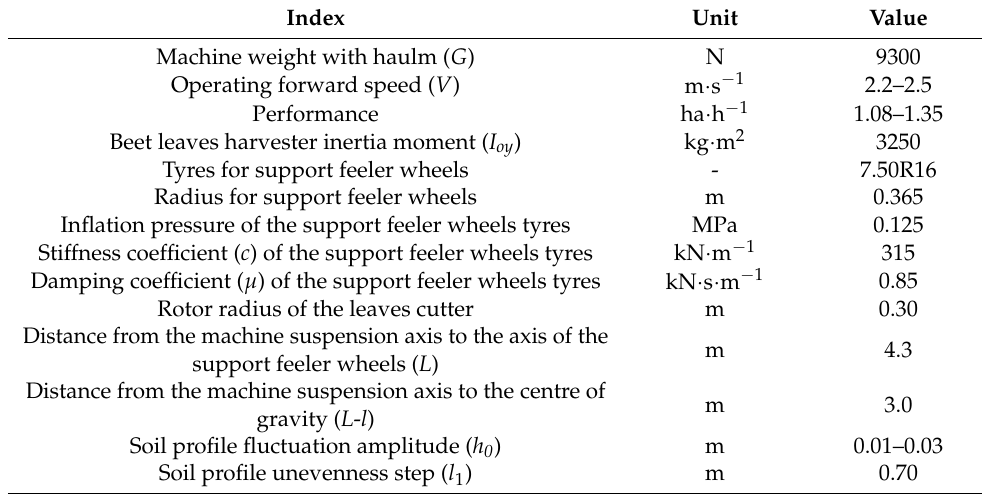
Table 1. Main technical parameters of the front-mounted beet leaves